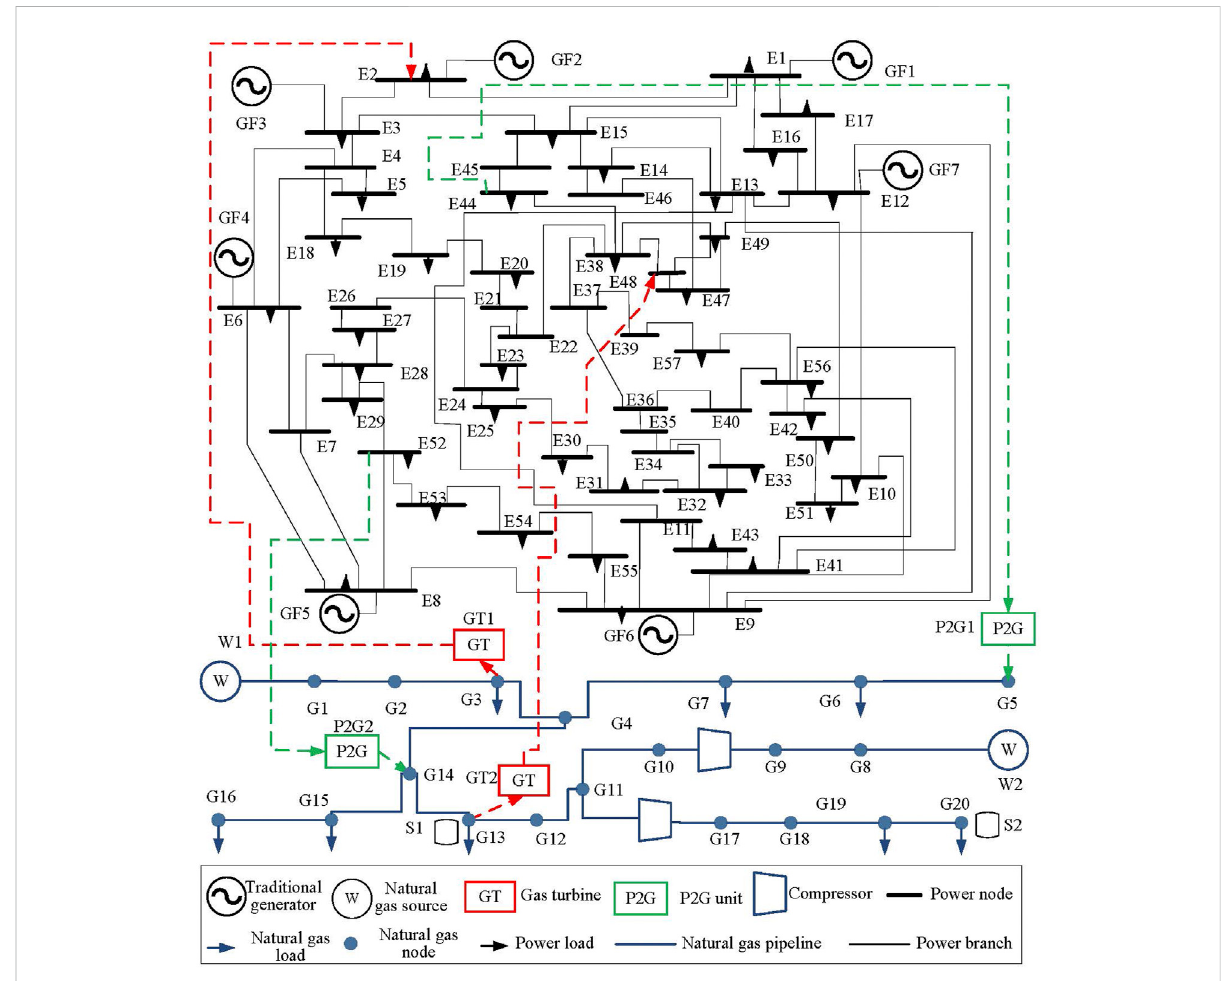
FIGURE 9 Simulation diagram of IEEE 57-NGS20 electricity-gas